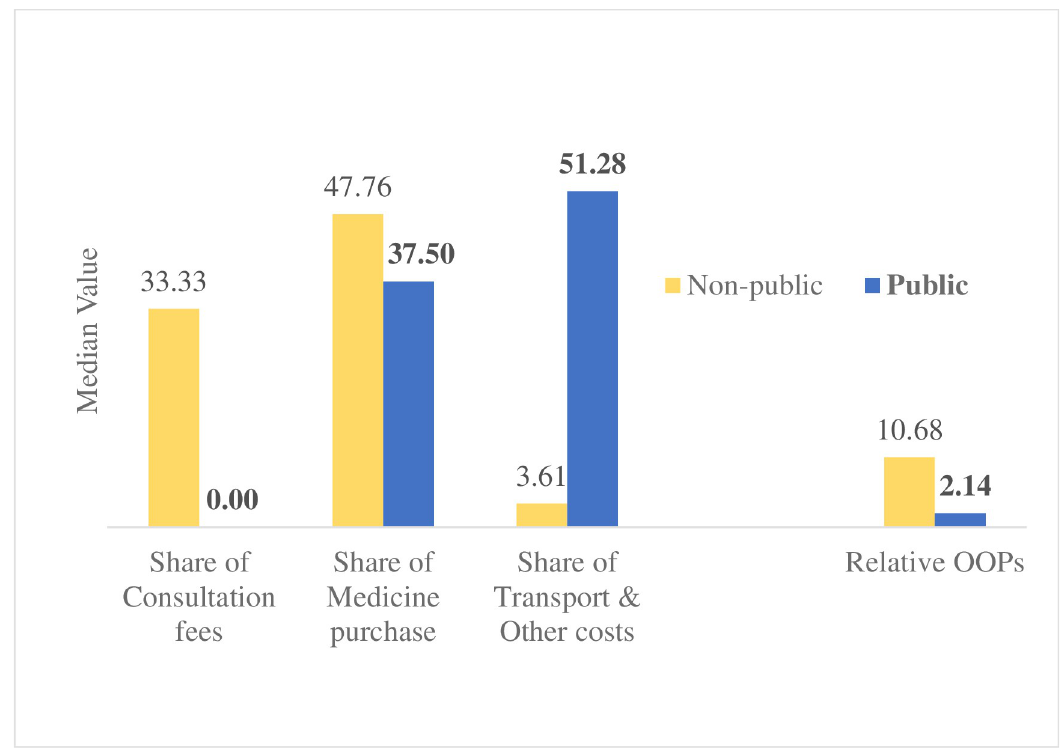
Fig 3. Median of OOPs share (%) and relative expenditure across the public and non-public health establishments (N = 159). Linear regression with GLM ( Table 3 ) demonstrated lower relative expenditure among people with primary or below level of schooling, compared to highest educational group; (Adjusted Coefficient (aCoeff) -10.65 (CI: -19.78, -1.51) and aCoeff completed primary no formal edu- -11.60 (CI: -20.88, -2.32)). The unemployed individuals had more relative cation/below primary